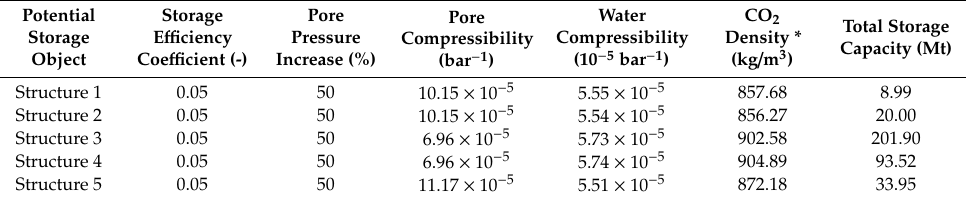
Table 4. Storage capacity estimation using compressibility method for structurally defined aquifers in